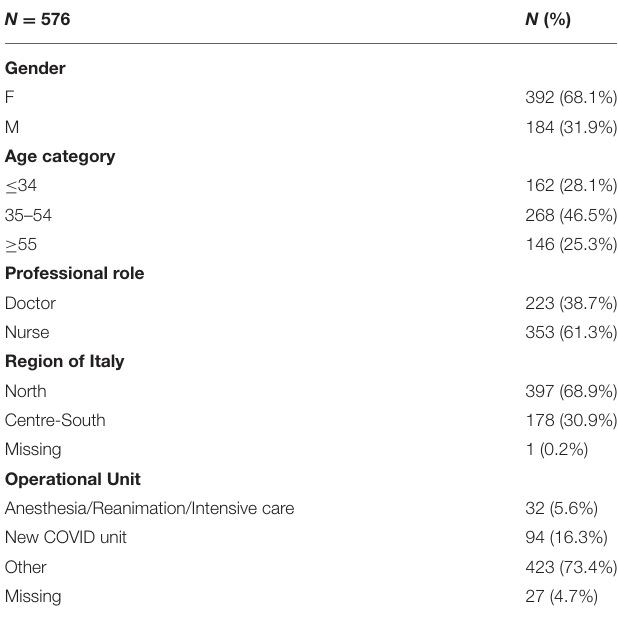
TABLE 1 | Demographic characteristics of the